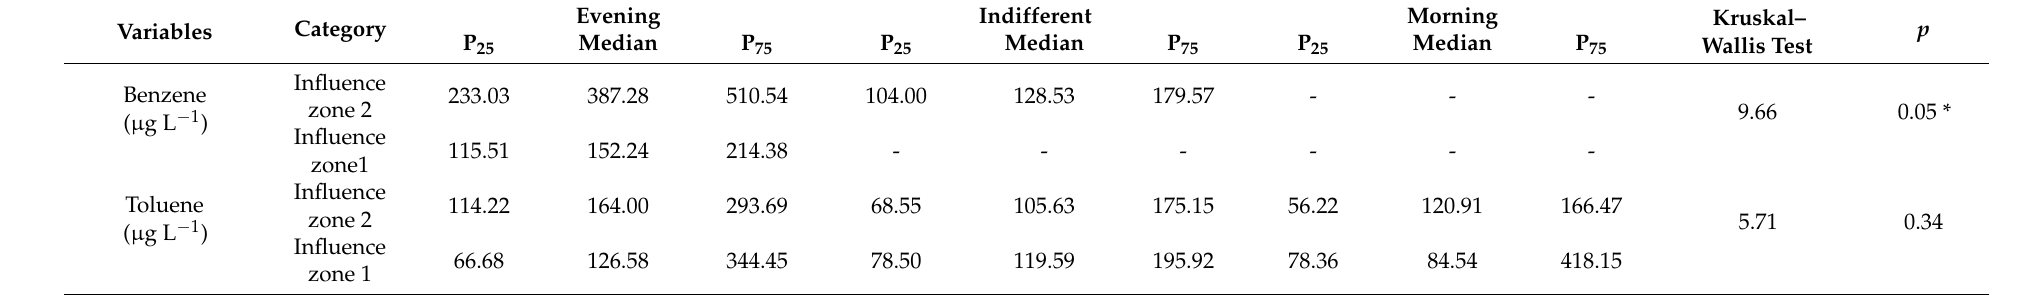
Table 8. Unmetabolized benzene and toluene in urine ( µ g L − 1 ) according to PER3 gene VNTR polymorphism and zone of influence.